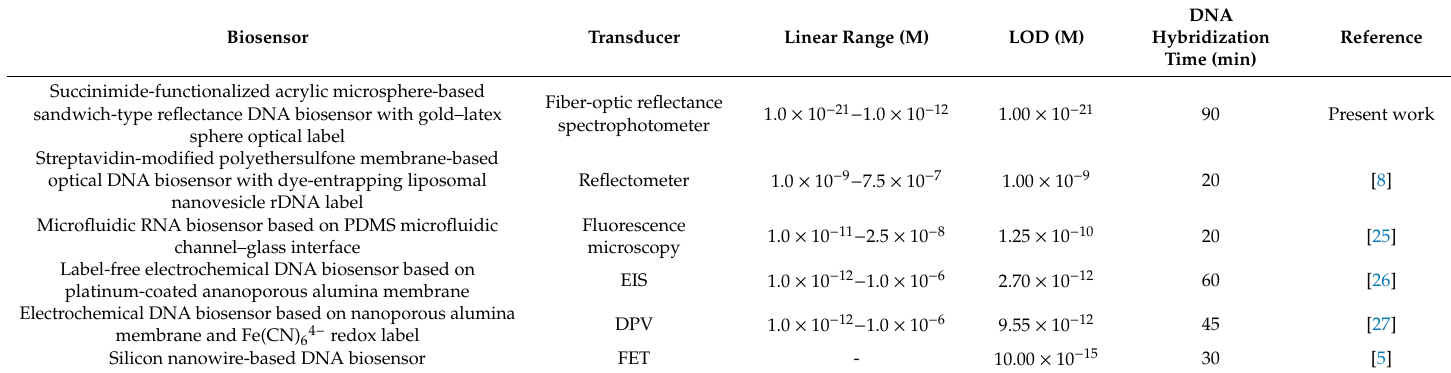
Table 3. Comparison of analytical performance between developed sandwich-type DNA micro-optode and previously reported optical and electrochemical nucleic acid biosensors in terms of dynamic linear response range, detection limit, and response time for specific detection of dengue